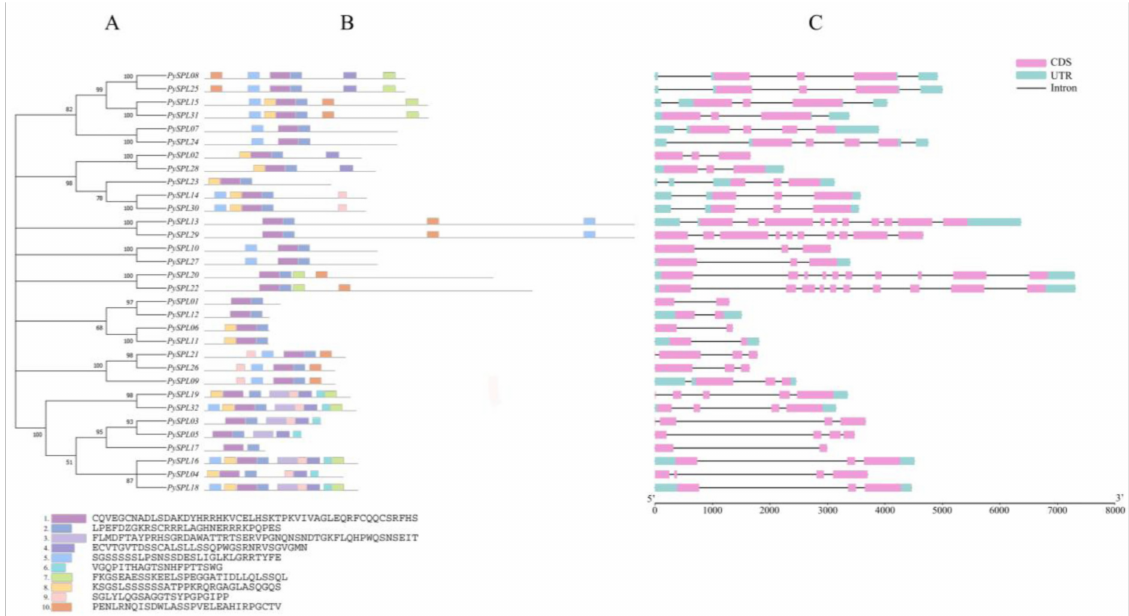
Figure 4. Phylogenetic relationship, conserved protein motif, and gene structure analysis of PySPLs. ( A ) A phylogenetic tree harboring amino acid sequence 32 of PySPLs by Neighbor-Joining method with 1000 bootstrap replicates. ( B ) Conserved motifs of 32 PySPLs arranged according to evolutionary relationships. Motifs of different colors have their corresponding amino acid sequences. ( C ) Gene structure of 32 PySPLs arranged according to evolutionary relationships, the exons, introns and UTRs are indicated by different colored boxes and